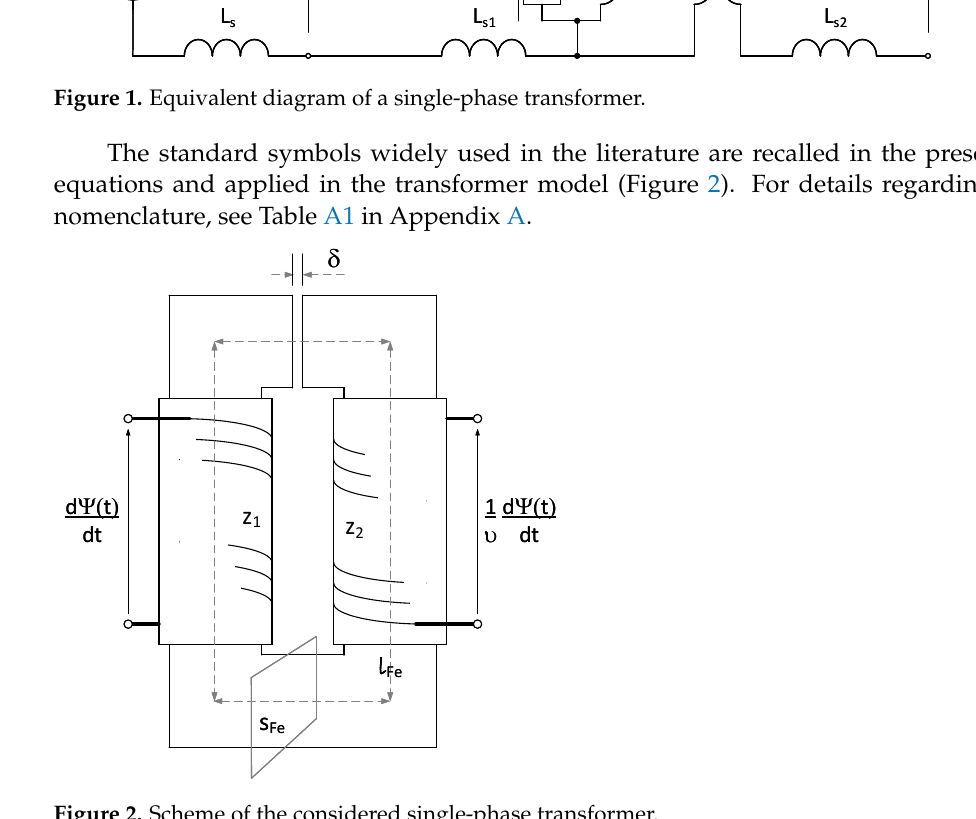
Figure 2. Scheme of the considered single-phase